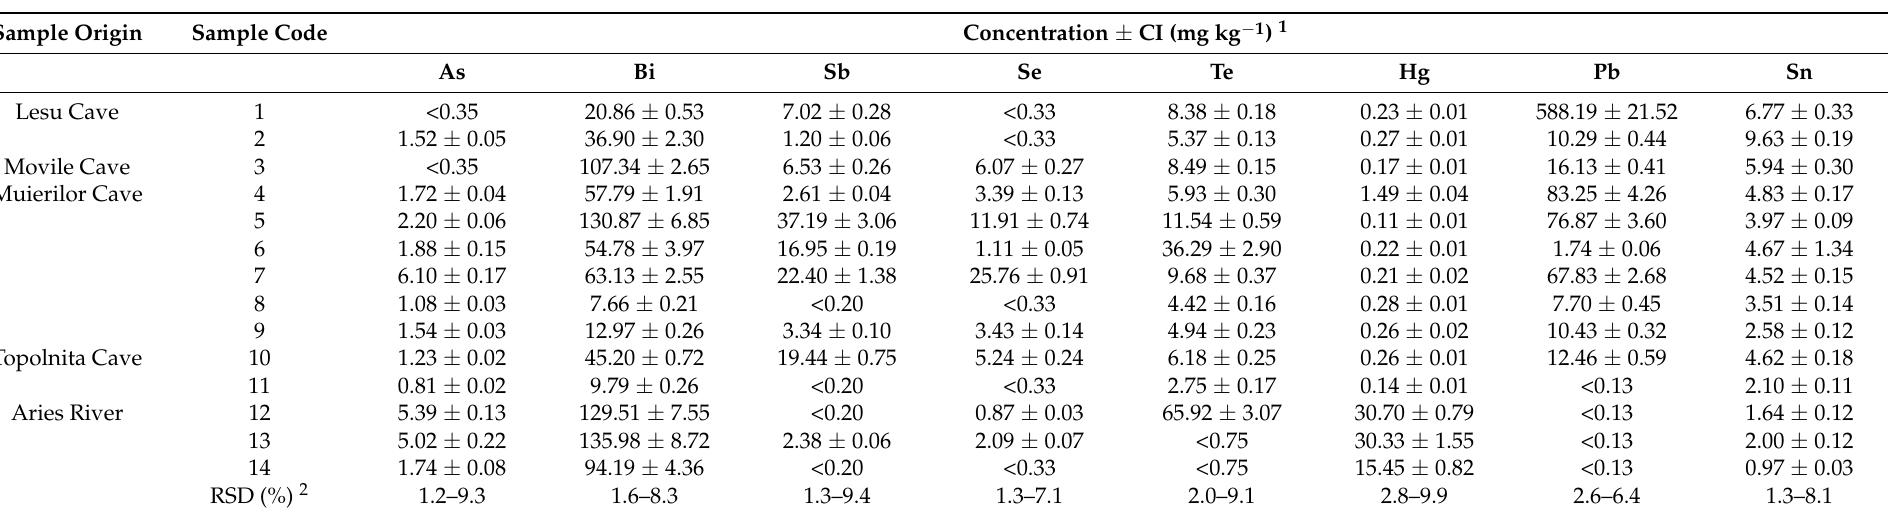
Table 6. Results for As, Bi, Sb, Se, Te, Hg, Pb, and Sn in test samples of cave and river sediment by the SSETV- µ CCP-OES method using Maya2000 Pro microspectrometer, and external